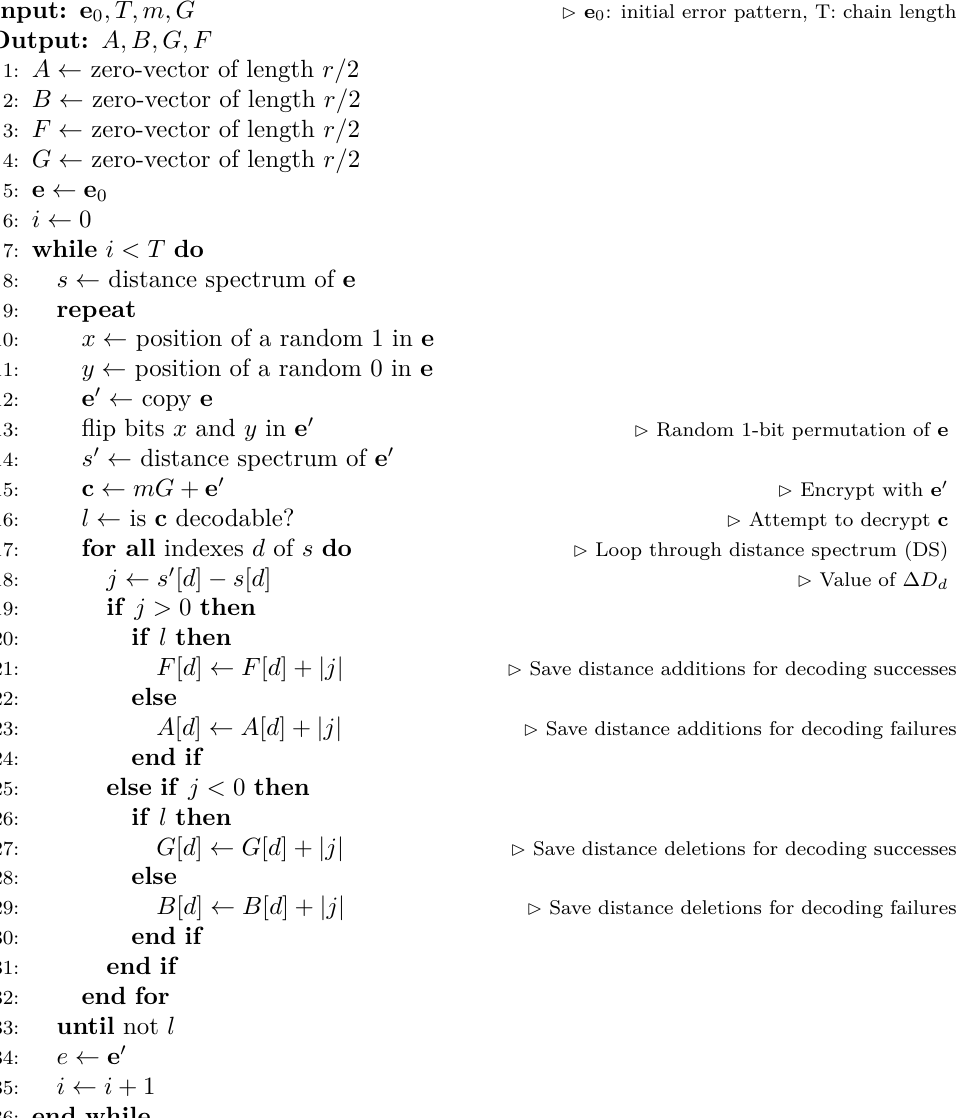
Algorithm 2 Algorithm for constructing error pattern chains and gathering distance information, without side channel